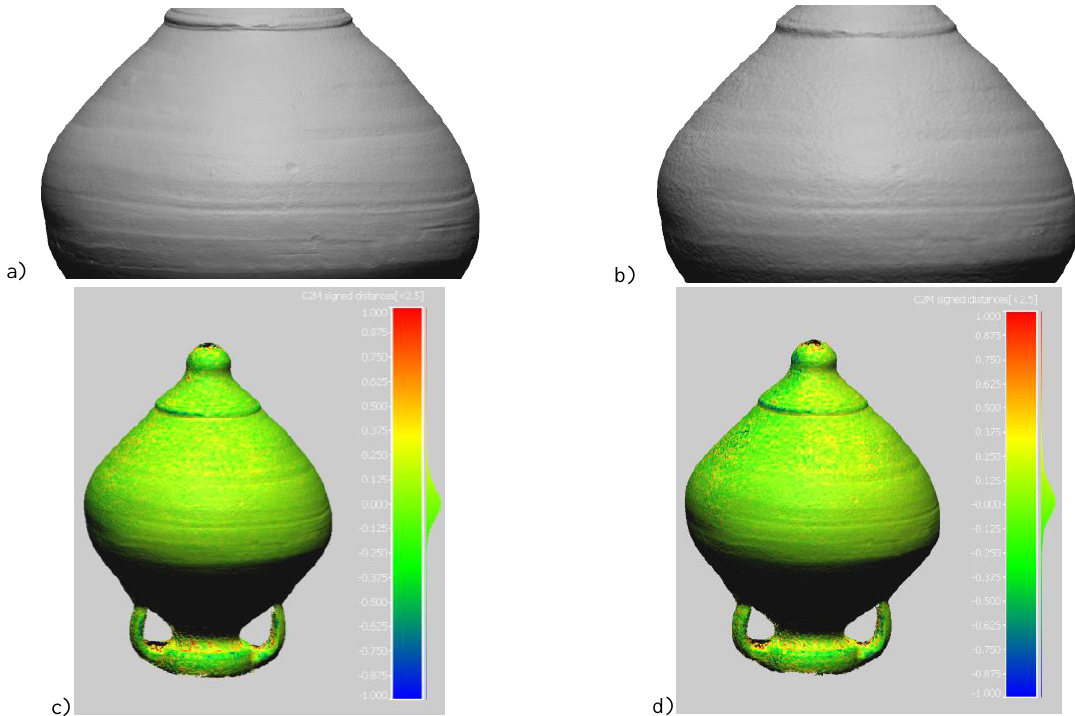
Figure 11. Particular of reference (a) and underwater (b) mesh model. Colour maps of Euclidean distances [mm] between the reference model and the one obtained with the underwater calibration approach a (c) and the underwater calibration approach c (d).